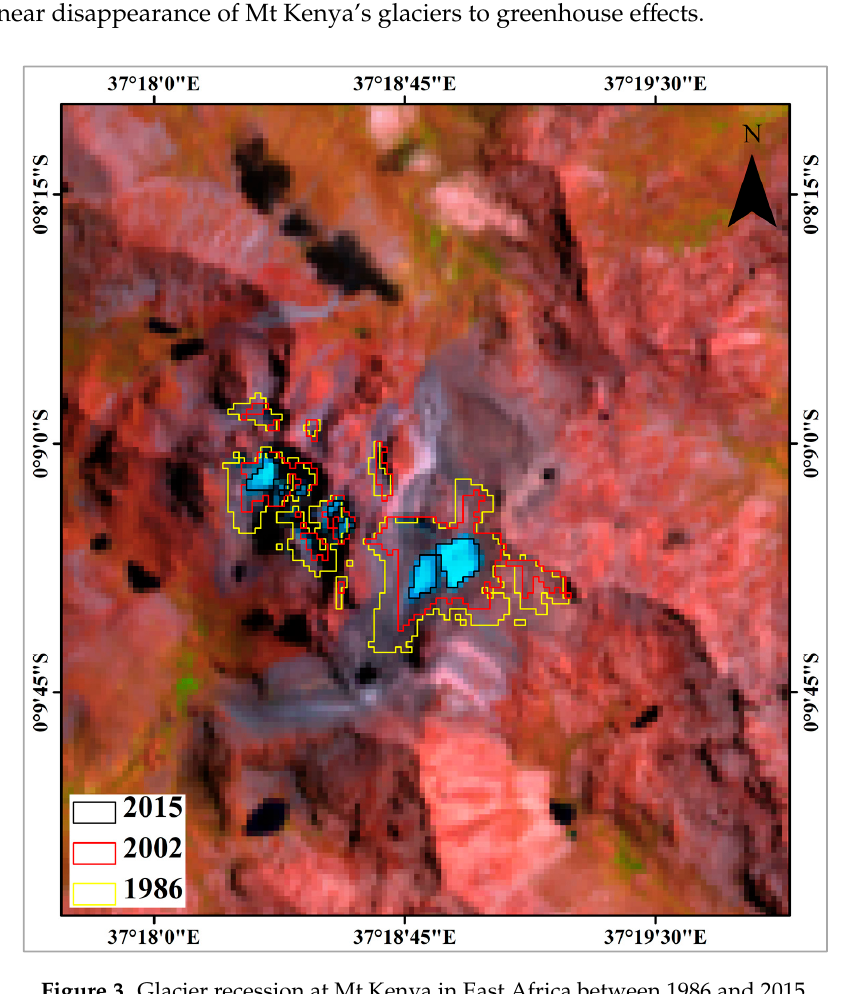
Figure 3. Glacier recession at Mt Kenya in East Africa between 1986 and 2015.